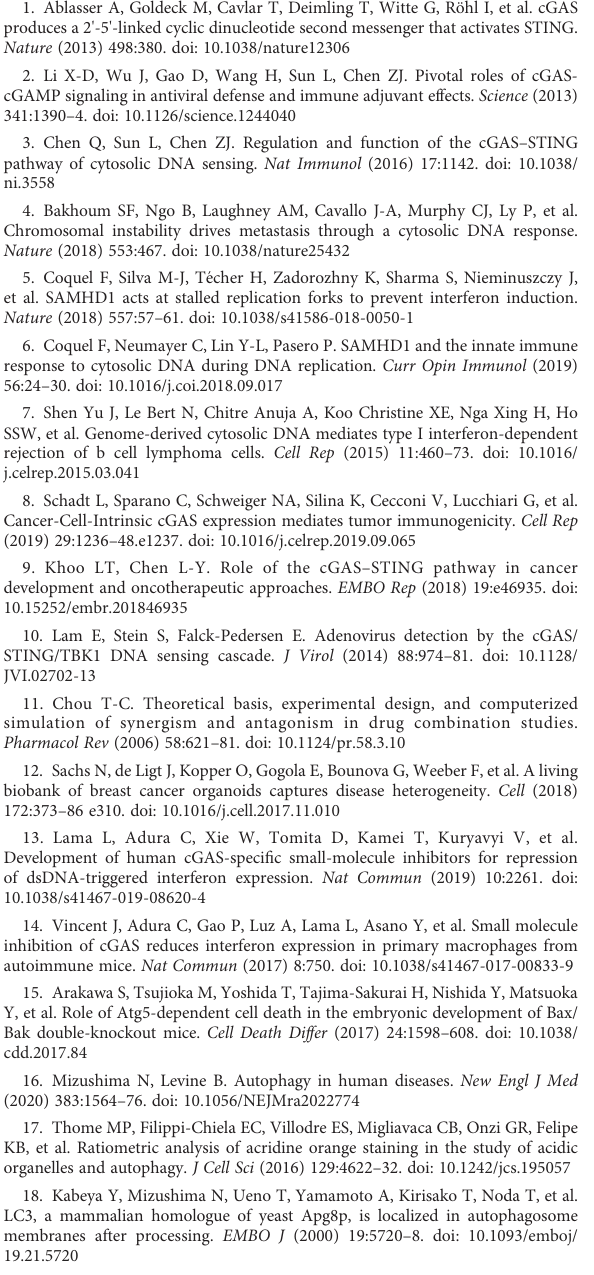
Hoechst 33342 (blue). (B, D) , The images in (A, C) , respectively, were quantitated and plotted. The data of three independent biological repeats areshownasmeans±SDandthestatisticalsigni fi cancewascalculatedby Student ’ stest. *,p< 0.05;**,p< 0.01;***, p<0.0001. (E,F) , MDA-MB-231 (E) and SUM159 (F) cells were treated in the conditions as described in (A, C) , and cell viability was determined by staining with crystal violet which was then measured by absorbance at OD595 nm. The data of three independent biological repeats are shown as means ± SD. *, p < 0.05; ***, p < 0.001. Statistical signi fi cance was calculated by Student ’ s